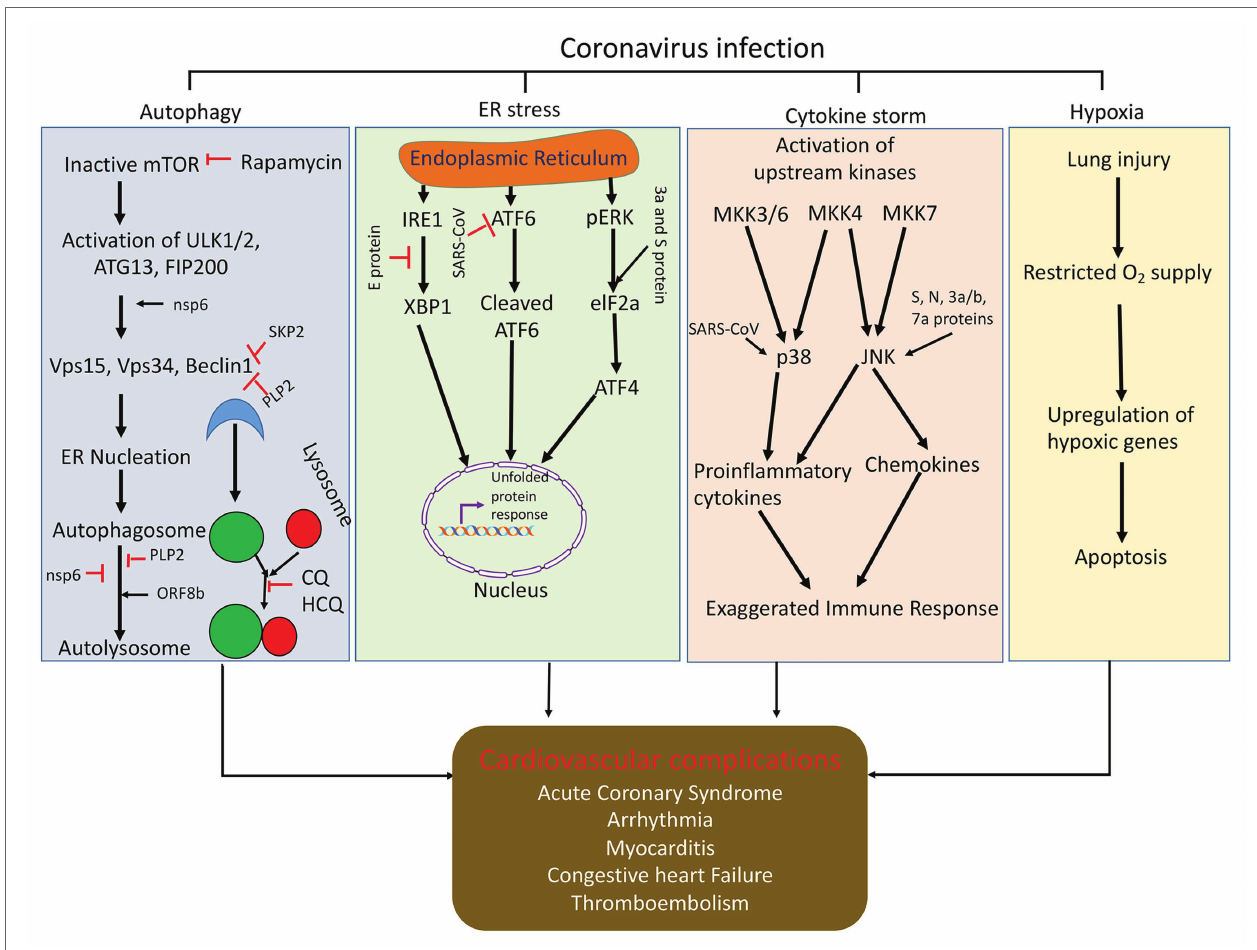
FIGURE 2 | Schematic representation of how coronavirus disrupts signaling pathways (autophagy, ER stress, cytokine storm, and hypoxia) and induces cell death. Autophagy is initiated by the formation of ULK1/2-ATG13-FIP200 complex and then generation of Beclin1 complex and initiation of autophagy vesicle formation. Coronaviral proteins can regulate autophagy through modulating function of autophagy regulatory protein at different stages of autophagy. Viral infection can inhibit ER function and induces ER stress and cell death. Viral protein expresses in ER and upregulates downstream ER stress signaling through modulation the function of ATF6, IRE1 and pERK, and elF2a. Upstream kinases in the JNK and p38 signaling pathways are activated upon infection with SARS-CoV. This activates the mitogen-activated protein kinase kinases (MKK3/6, MKK4, and MKK7). Mkk3/6 and Mkk4 activate p38. SARS-CoV can also directly activate p38 or the SARS-CoV E protein can activate syntenin, which in tune activates p38. These pathways activate proinflammatory cytokine production. MKK4 and MKK7 can also activate JNK. SARS-CoV s, N, 3a, 3b, and 7a proteins can also directly activate JNK. This pathway activates proinflammatory cytokine production and induction of apoptosis. Also, due to viral infection in the lungs, there is restricted supply of O 2 in the blood, which generate hypoxia and cell death and major organ dysfunction; CQ, chloroquine and HCQ,